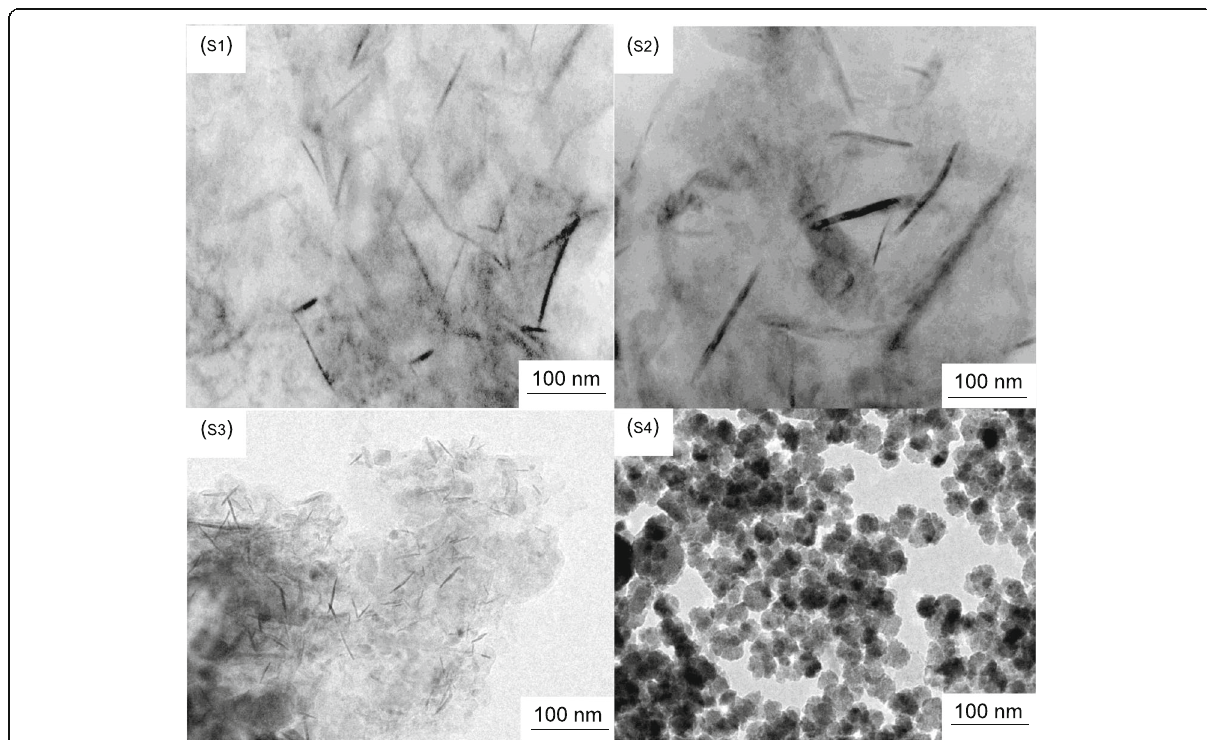
Fig. 2 TEM micrographs of as-synthesized Fe 3 O 4 with varying molarity of FeCl 2 . Notice the change in morphology with varying